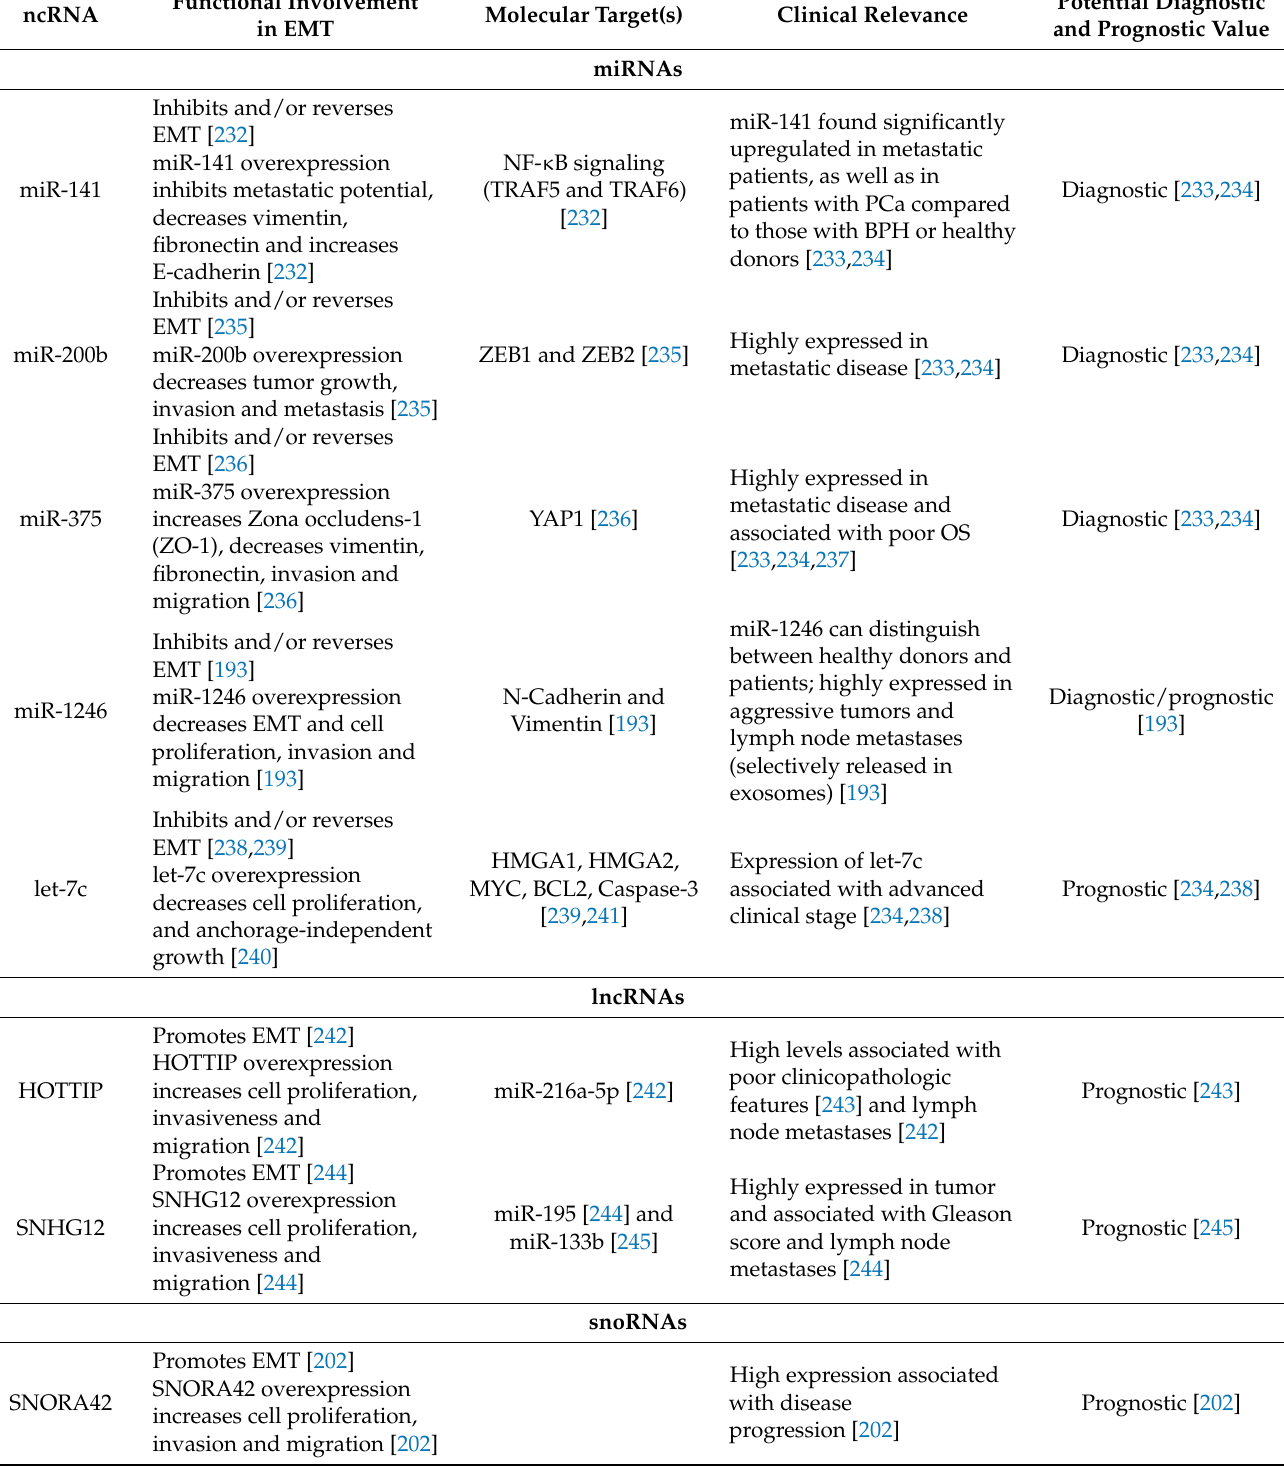
Table 3. Diagnostic and Prognostic Biomarker Potential of Several EMT-Associated ncRNAs in Prostate Cancer. Several non-coding RNAs functionally involved in prostate cancer EMT have potential diagnostic and/or prognostic clinical